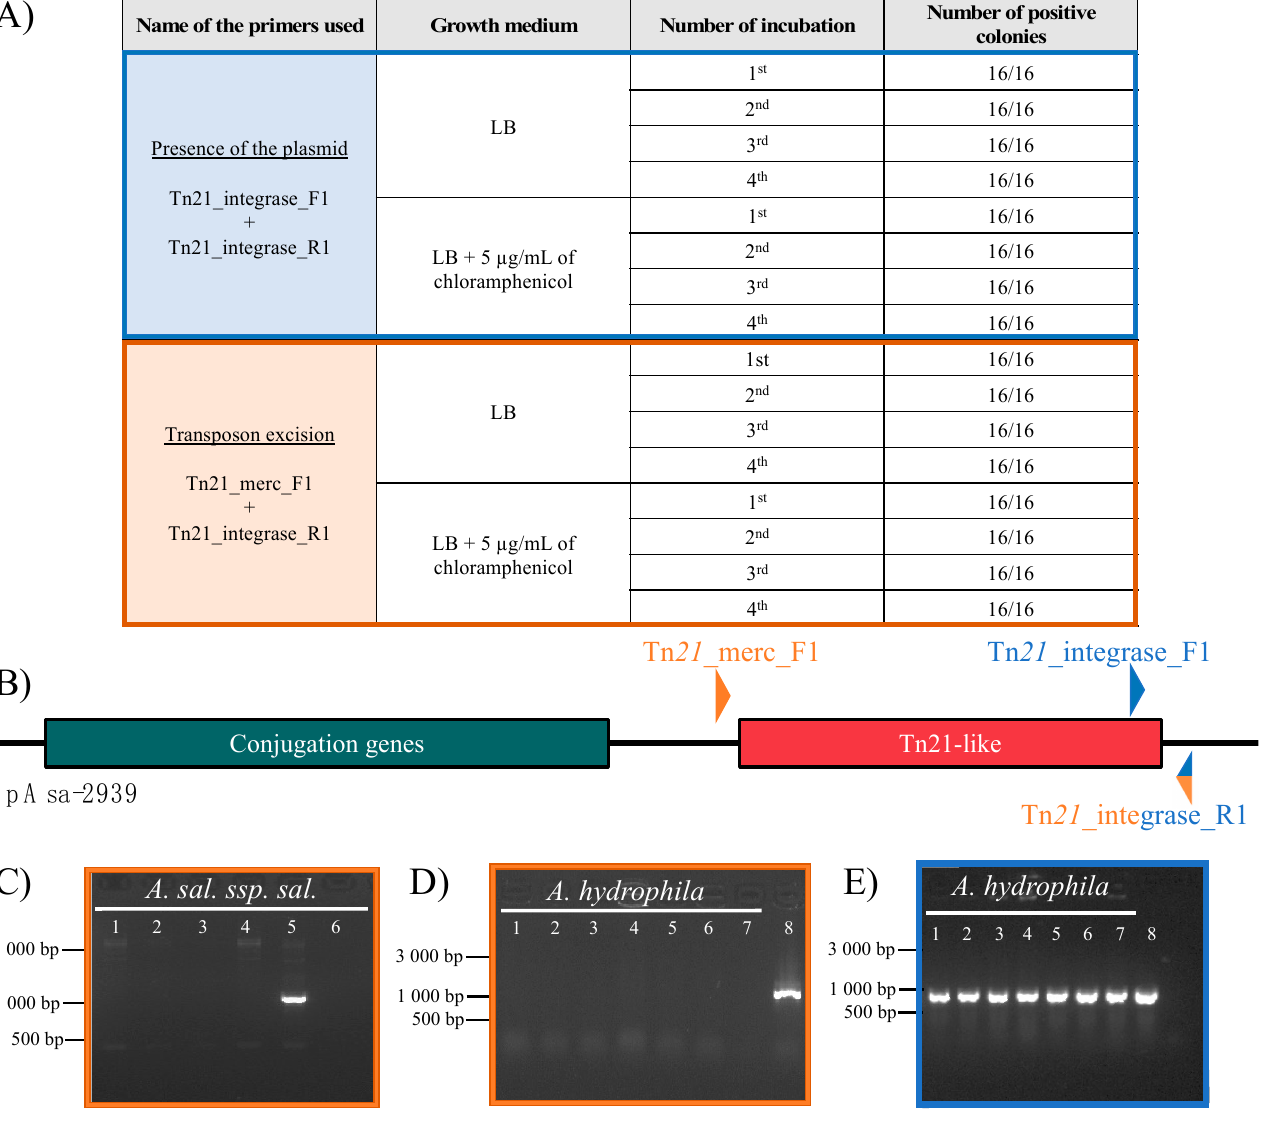
Figure 3. Transposon instability in SHY15-2939 confirmed by PCR analysis. ( A ) Analysis of different lysates from A. salmonicida subsp. salmonicida SHY15-2939 grown on different medium using different primers. This confirms the excision of the transposon in a part of the bacterial population (in orange) while the majority of the bacteria keep an intact plasmid (in blue). ( B ) Schematic representation of pAsa-2939 found in A. salmonicida subsp. salmonicida SHY15-2939. The region in green corresponds to the gene involve in the conjugation of the plasmid and the Tn21 -like is represented by the region in red. The primers are shown in blue or orange depending on the combination used for the PCR. The Tn21_integrase_R1 primer was used in both PCR reaction. ( C ) Confirmation of the specificity of the Tn21_Merc_F1 and Tn21_integrase R1 primers (orange combination) for transposon excision. Strains tested are in this order from lane 1 to 6: 01-B526, 01-B516, A449, SHY16-3432, SHY15-2939 and water as a negative control. ( D ) The PCR result from 7 trans-conjugants of A. hydrophila with the pAsa-2939 plasmid (line 1 to 7) using the primers Tn21_Merc_F1 and Tn21_integrase R1 (orange combination). The eighth well corresponds to the positive control which is A. salmonicida ssp. salmonicida SHY15-2939. ( E ) A PCR amplification of the primers Tn21_integrase_F1 and Tn21_integrase_R1 (blue combination) for A. hydrophila with pAsa-2939 on the same samples than in D. To confirm the presence of the plasmid without the transposon, the genomic DNA of Strain SHY15-2939 was sequenced with long-read sequencing (PacBio SMRT